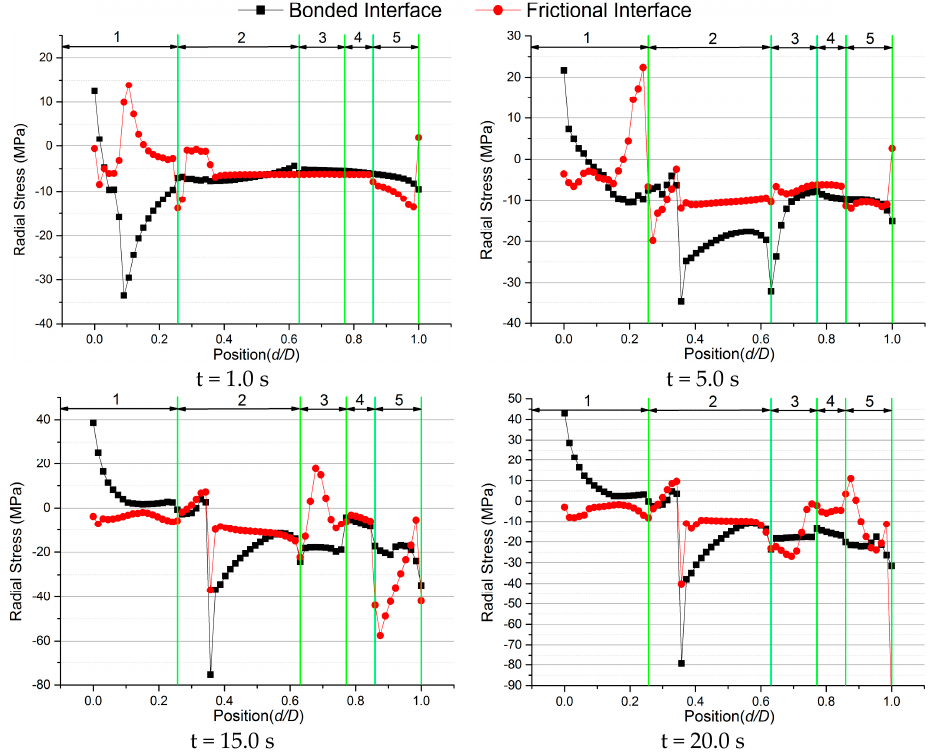
Figure 13. Radial stress variation curves of the passageway for the two different types of interface treatments.